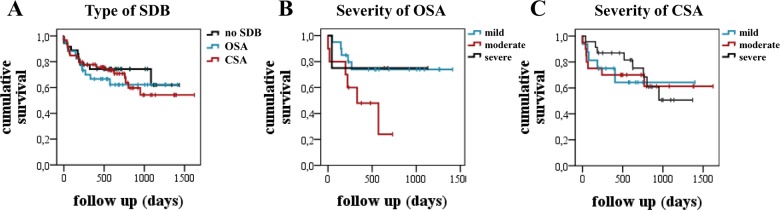
Kaplan-Meier estimate of survival.Kaplan-Meier estimates of survival with regard to the type of sleep disordered breathing (SDB, Panel A) and the severity of obstructive (OSA, Panel B) and central sleep apnoea (CSA, Panel C), respectively, show no significant differences in mortality between the groups. Mild SDB: AHI 5–14.9/h, moderate SDB: AHI 15–29.9/h, severe SDB AHI >30/h.